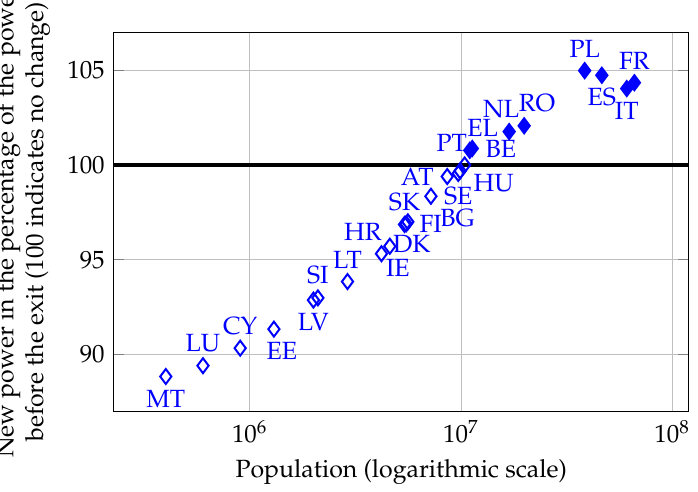
Figure 4. Change in power due to Czexit in the 26-member EU (after Brexit and Germany’s exit) with populations for 2015, adjusted Shapley–Shubik